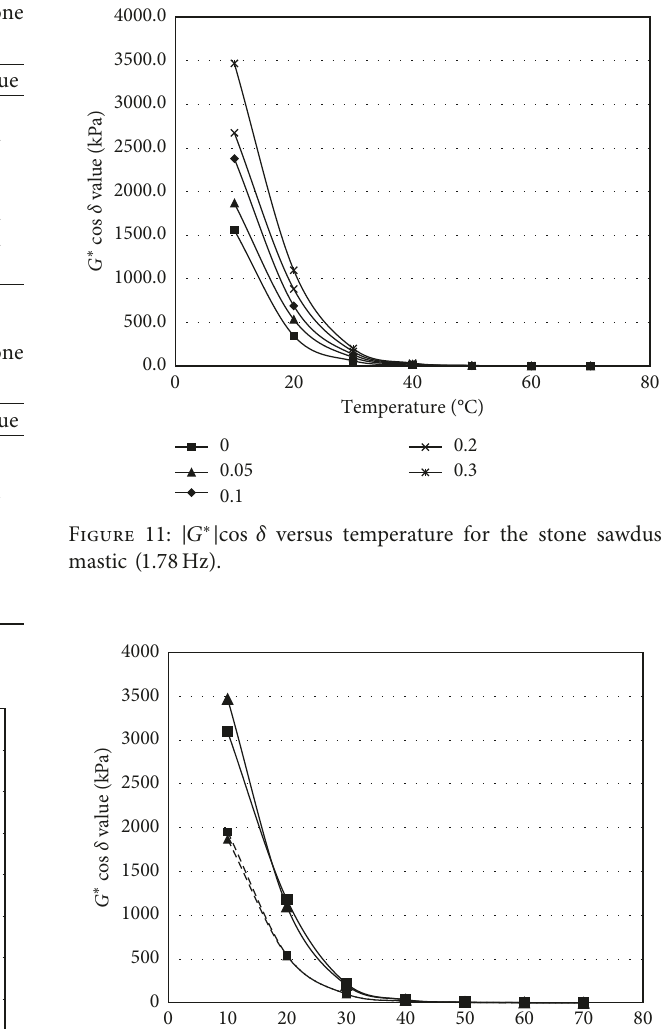
Table 6: Relationship between mastic (1.78Hz).